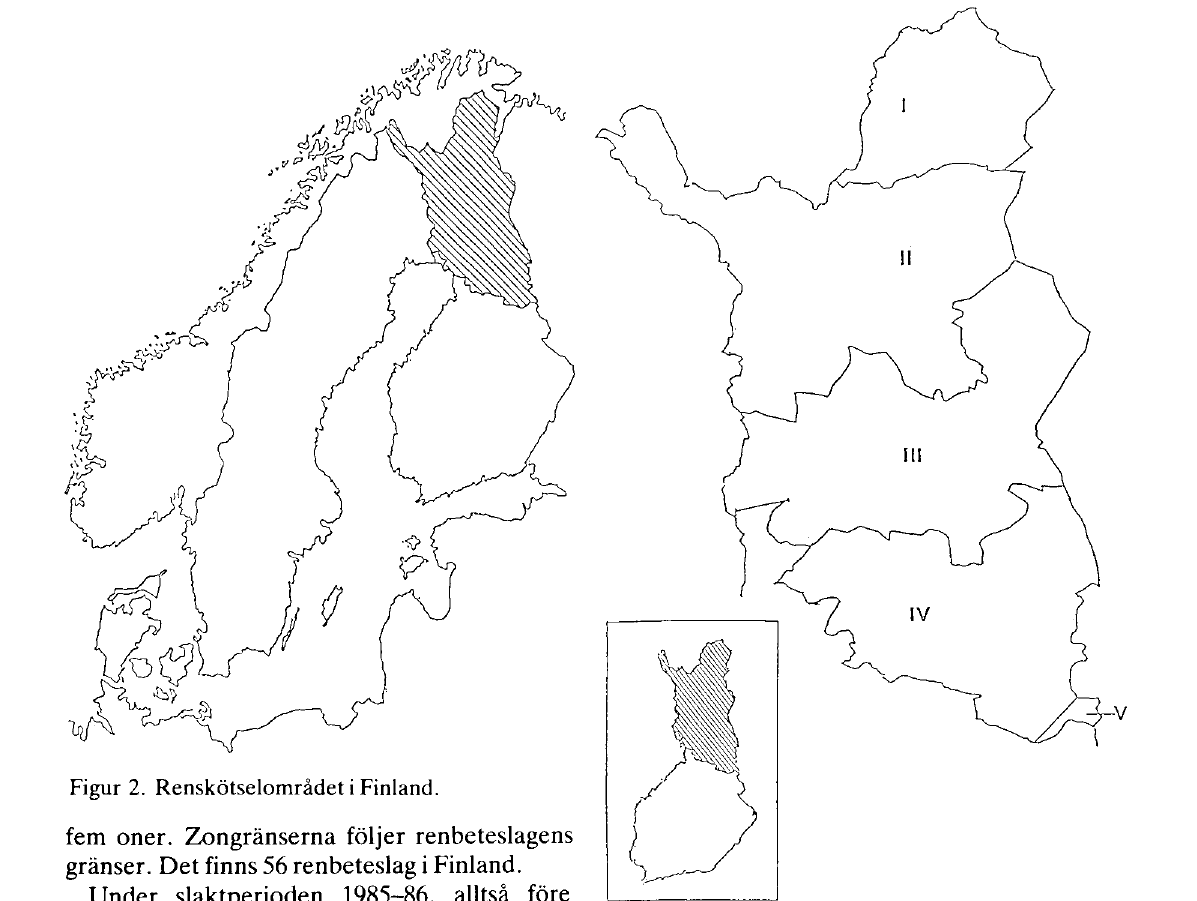
Figur 3. Renskotselområdets fem zoner. tenskapliga åndamål eller förstördes.